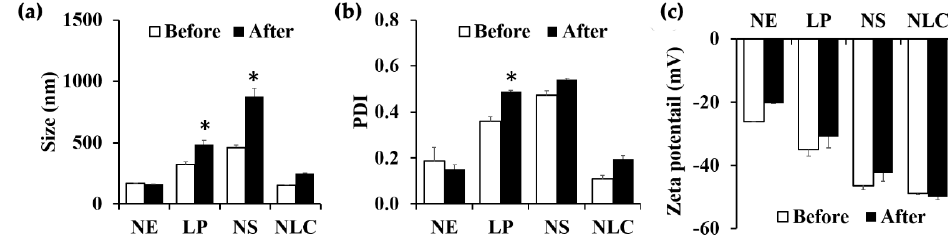
Figure 5. Stability of nanodelivery systems after heating–cooling cycles: ( a ) Internal droplet size; ( b ) PDI; and ( c ) zeta potential of nanoemulsion (NE), liposome (LP), niosome (NS), and nanostructured lipid carrier (NLC) before ( (cid:3) ) and after ( (cid:4) ) 8 cycles of heating–cooling cycles. Asterisk (*) denotes significantly different, p < 0.05.